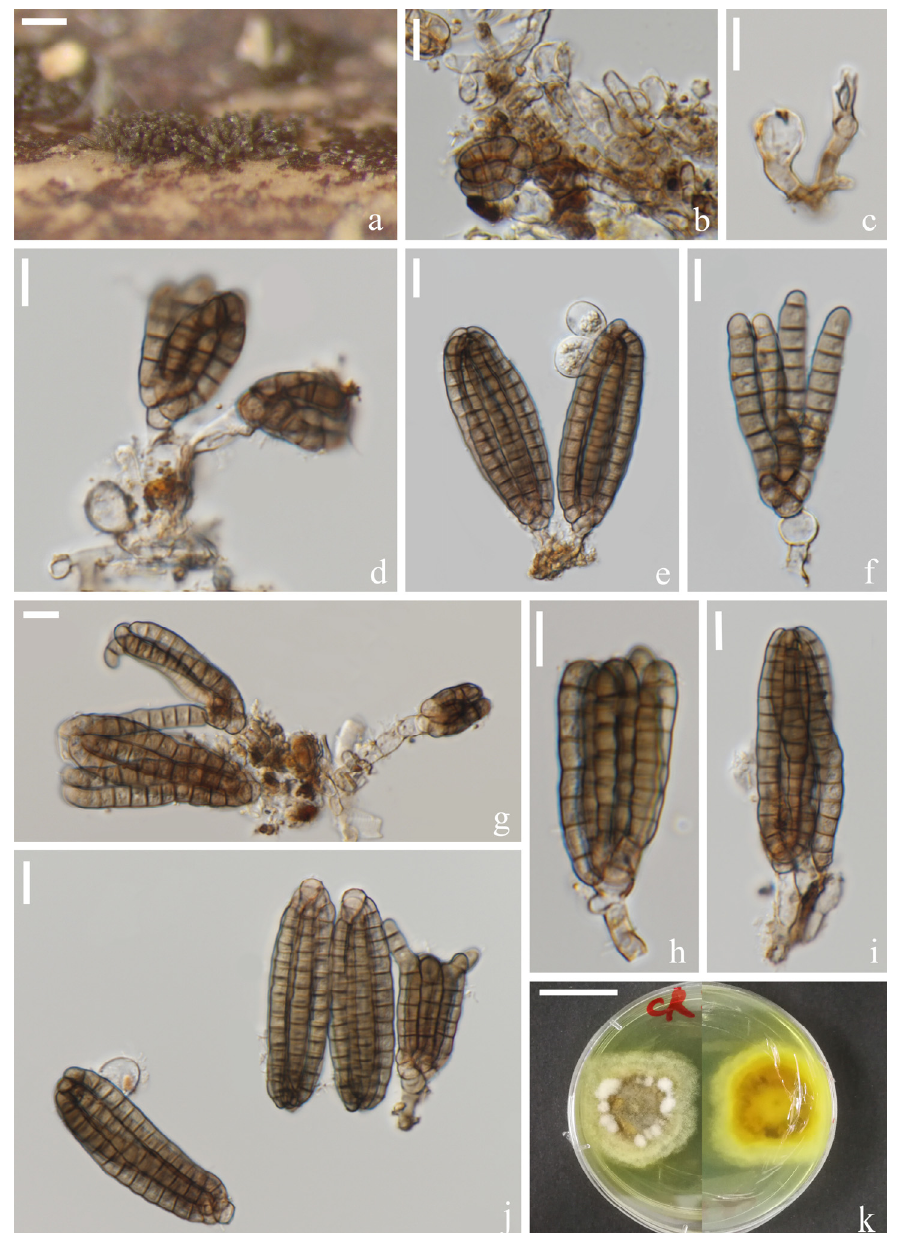
Figure 5. Dictyocheirospora aquadulcis (MFLU 22-0201). ( a ) Colonies on the substratum. ( b ) Conidiomata. ( c ) Conidiophores. ( d , e ) Conidiophores and conidia. ( f ) Conidiophores, conidia and appendages. ( g – i ) Conidiogenous cells and conidia. ( j ) Conidia. ( k ) Culture colonies on PDA, reverse (left) and obverse (right). Scale bars: ( a ) 100 μ m, ( b – j ) 20 μ m and ( k ) 2 cm.